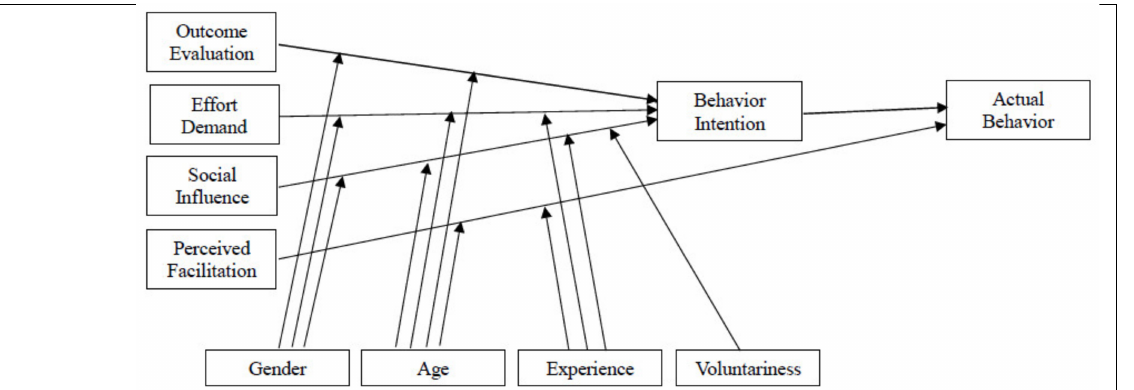
Figure 1. The Unified Technology Acceptance and Use of Technology Theory (Modified from [13]).